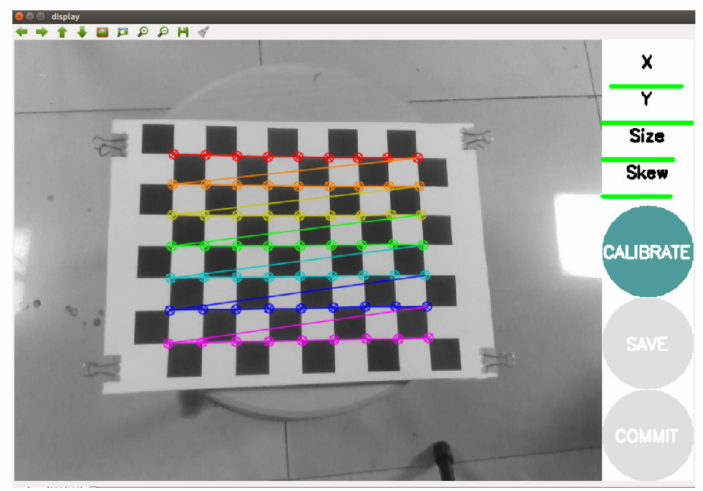
Figure 17. Camera internal parameters